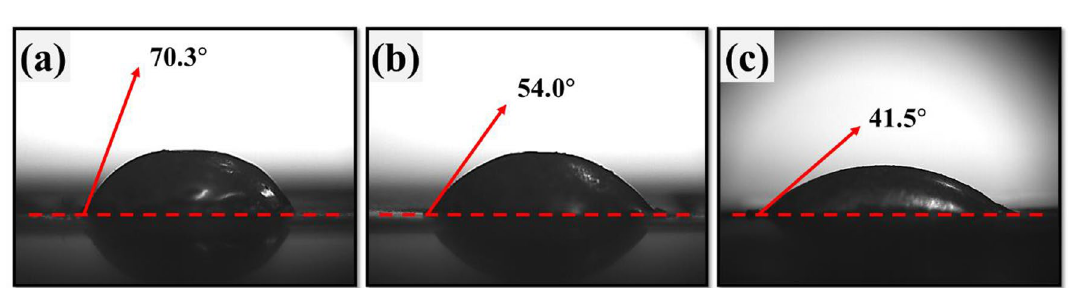
Figure 10. Solder contact angle measurement of an ( a ) IPL sintered Cu NPs electrode, ( b ) IPL sintered CPN electrode, and ( c ) Ni electroplated CPN electrode